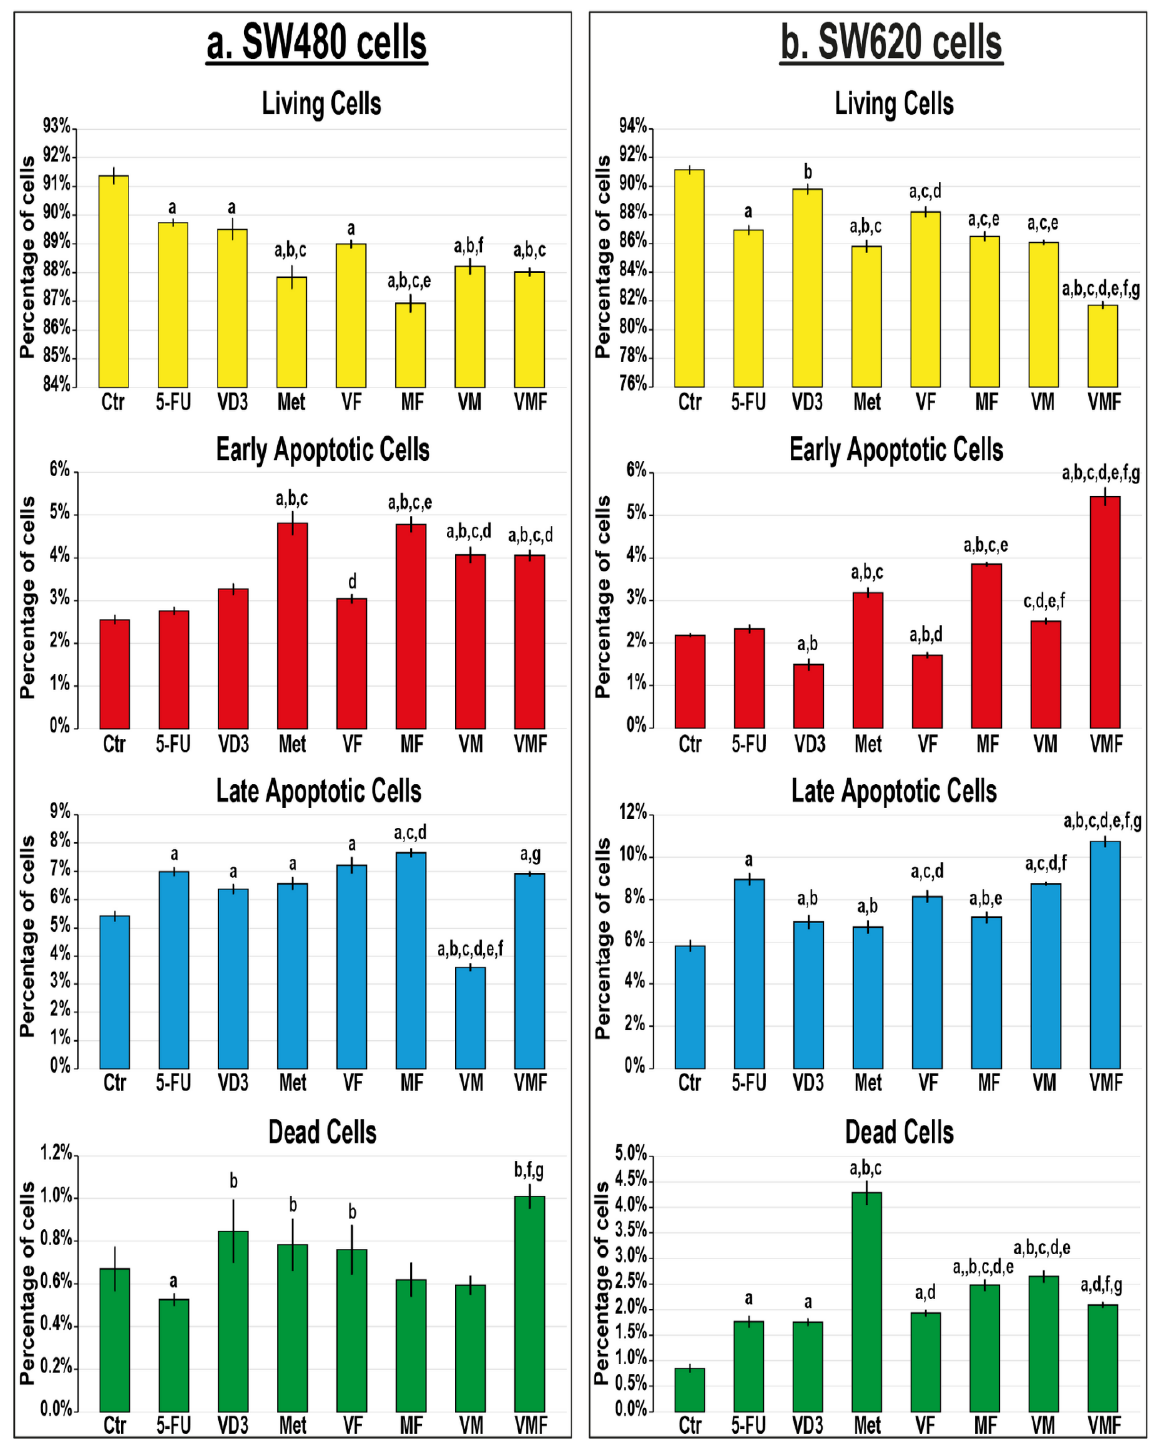
Figure 6. Percentages (mean ± SD) of living, early and late apoptotic, and dead cells in untreated control cells, and following treatments with 5-fluorouracil, calcitriol, and/or metformin single (5-FU, VD 3 , and Met), dual (VF, MF, and VM), and triple (VMF) therapies for 12 h in the ( a ) SW480 and ( b ) SW620 colon cancer cell lines (n = 3/group; data were analysed by ANOVA followed by Games–Howell post hoc tests and are shown as the mean ± SD; a = p < 0.05 compared with control untreated cells; b = p < 0.05 compared with 5-FU monotherapy; c = p < 0.05 compared VD 3 monotherapy; d = p < 0.05 compared with Met monotherapy; e = p < 0.05 compared with VF dual therapy; f = p < 0.05 compared with MF dual therapy; and g = p < 0.05 compared with VM dual